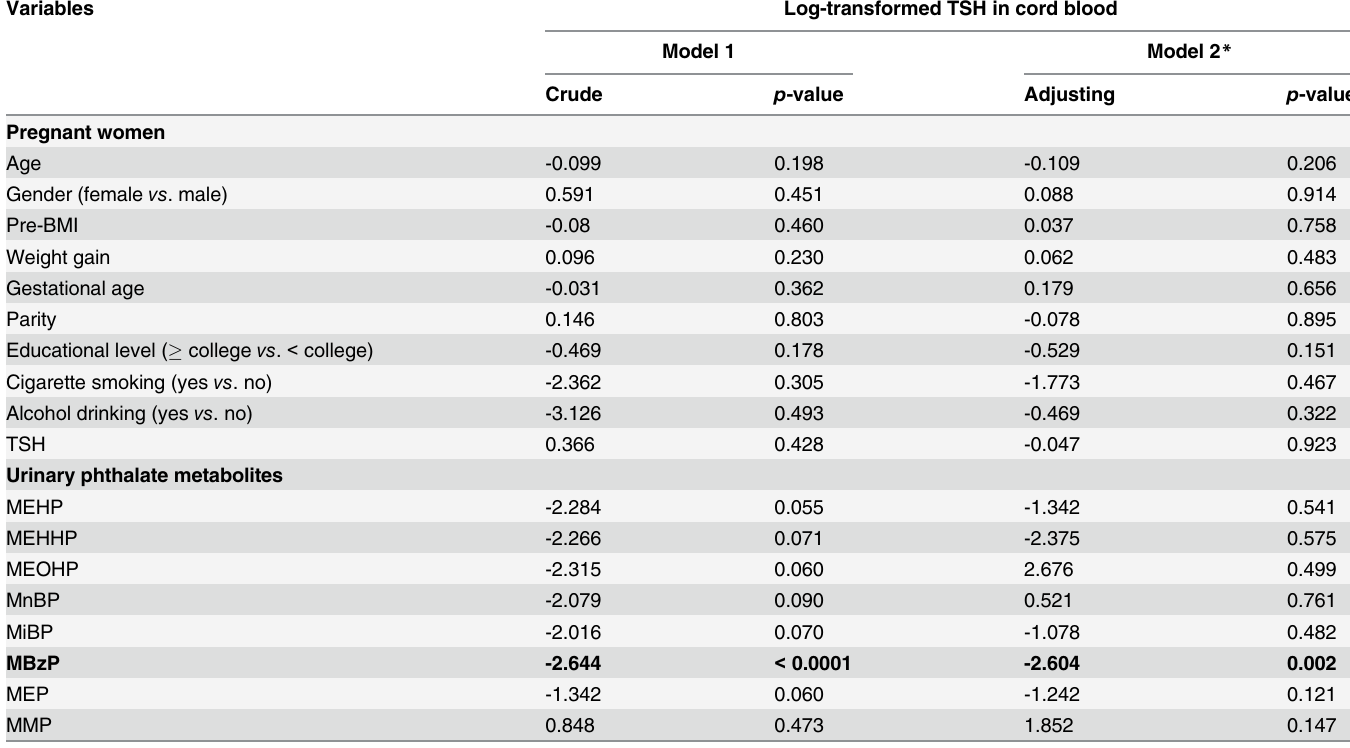
Table 4. Relationship of thyroid stimulating hormone (TSH) in cord blood with urinary phthalate metabolites in pregnant women in crude and full